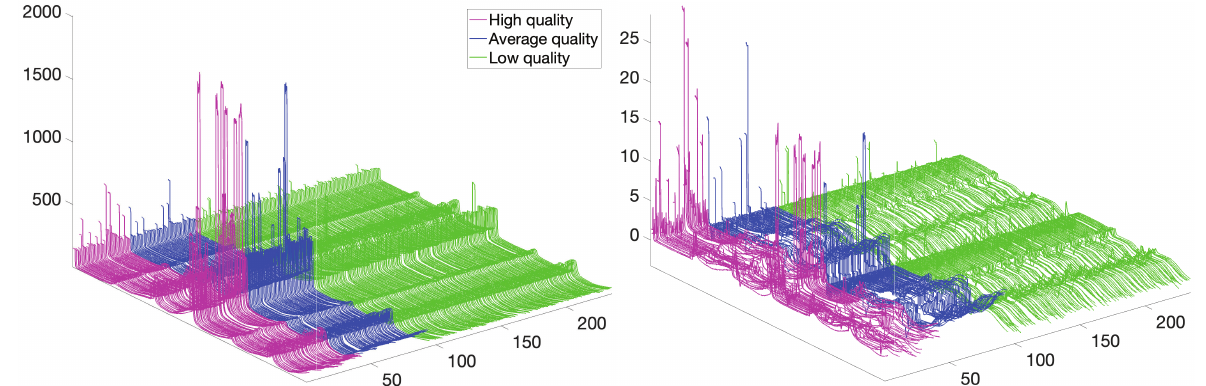
Figure 8. Three-dimensional plot of the unfolded data in dataset #2. Initial values ( left ) and MCUGS signal ( right ). All experiments are shown superposed (3330 values per 6 sensor signals for 235 experiments).